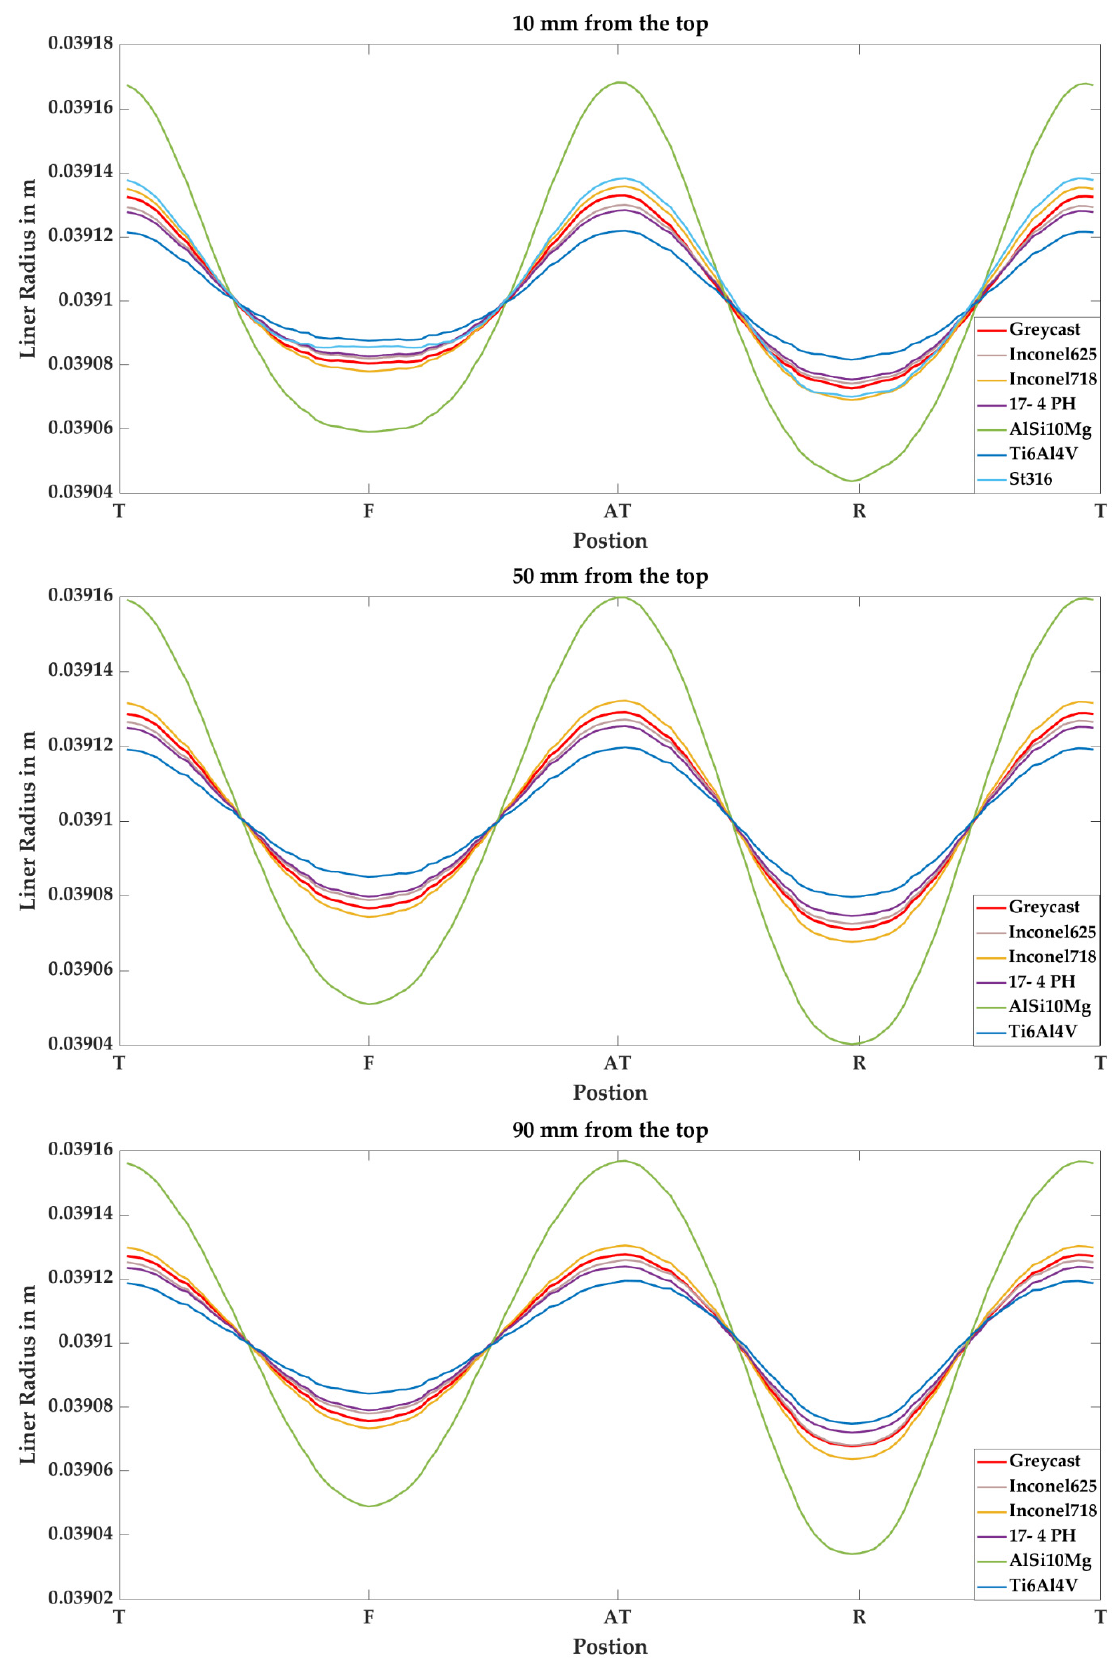
Figure 4. Radius of the cylinder liner at elevations 10, 50 and 90 mm.